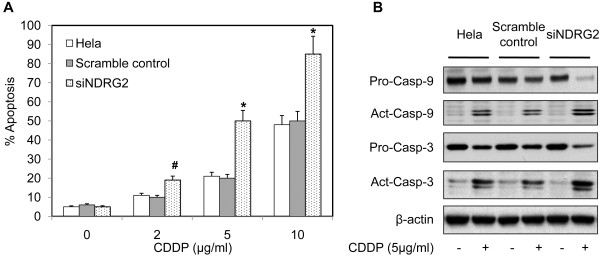
Down-regulation of NDRG2 enhanced cisplatin-induced apoptosis of Hela cells. Hela cells and the stable variants were exposed to different concentration of cisplatin (CDDP) for 24 h. The apoptotic cells were either stained with annexin V-FITC and propidium iodide (PI) and examined with flow cytometry, or subjected to Western blot. A. The percentage of apoptotic cells was presented. # p < 0.05 vs Hela and scramble control. * p < 0.01 vs Hela and scramble control. B. The expression of caspase-3 (Casp-3) and caspase-9 (Casp-9) was detected by Western blot analysis using β-actin as loading control. Shown are representative of 3 independent experiments. Act, active caspase. Pro, procaspase.